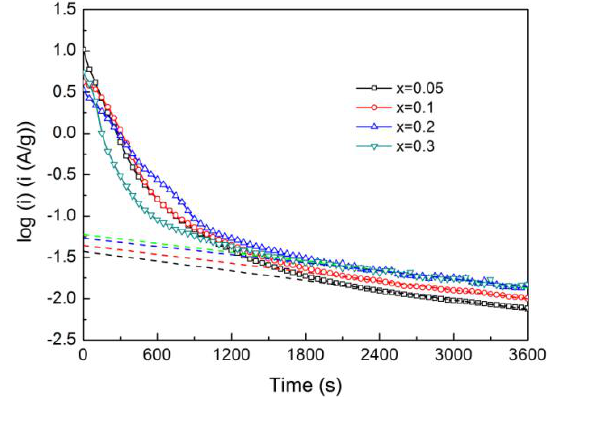
Figure 9. Semilogarithmic curves of discharge curves of La (Mg Zr )(Ni Co ) 0.7 0.3– x x 0.85 0.15 3.5